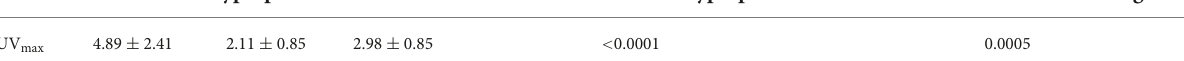
TABLE 3 Difference in quantitative criteria among adenoma, hyperplasia, and other diagnosis. Adenomas Hyperplasias Others* Between adenomas and hyperplasias Between adenomas and other diagnosis